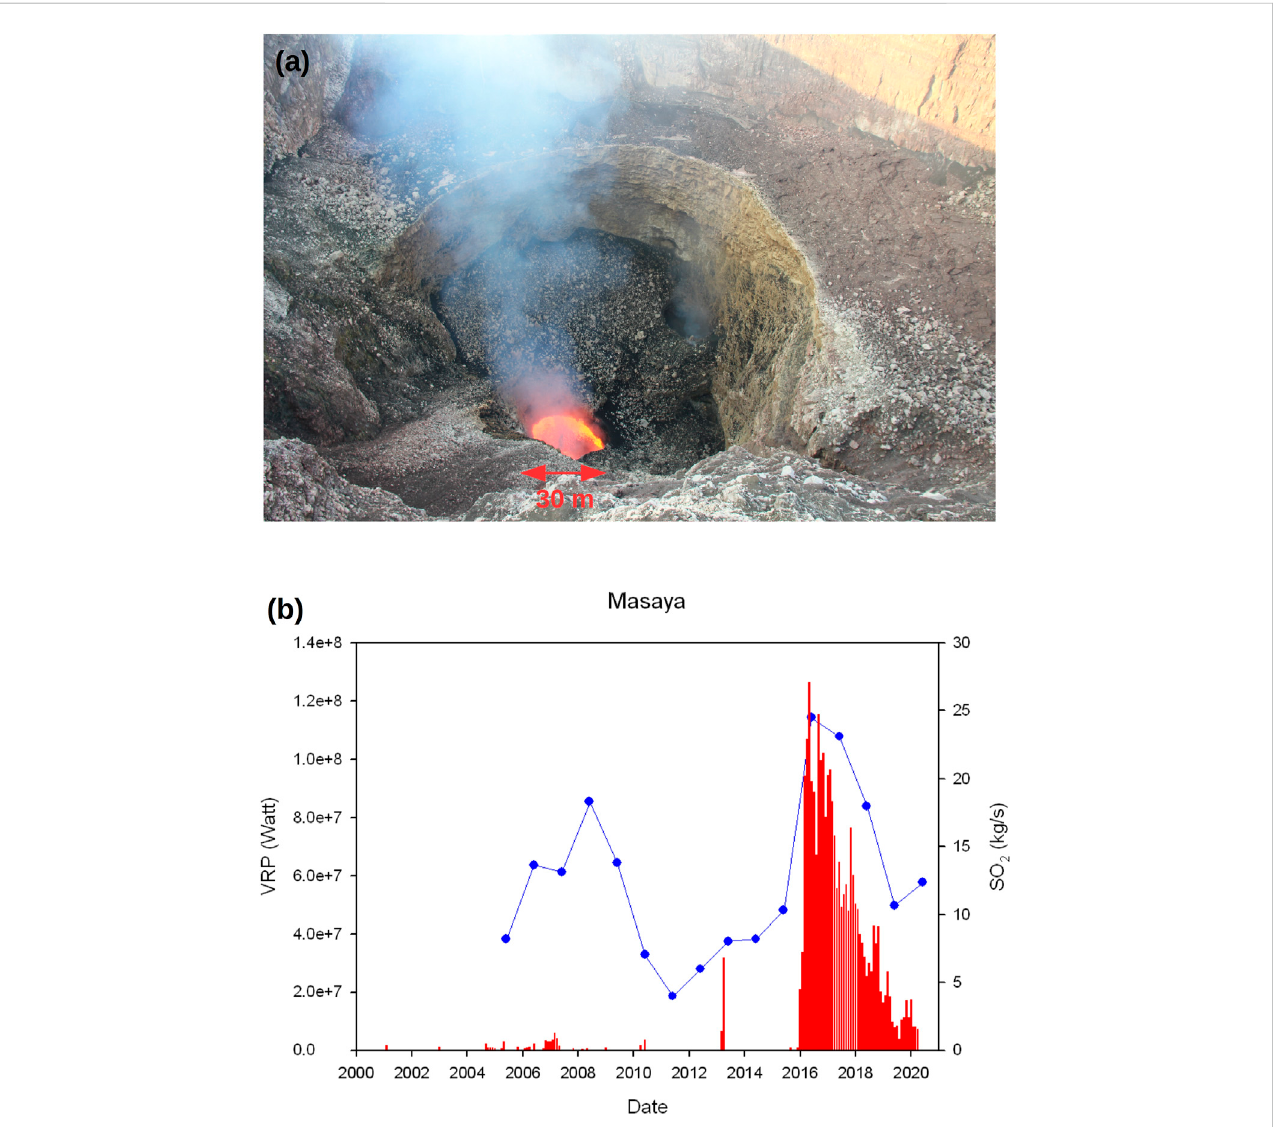
FIGURE 7 (A) Masaya lava lake at its highest level, in May 2016. (B) Time series of the yearly-averaged SO 2 fl ux and daily Volcanic Radiative Power from the Masaya